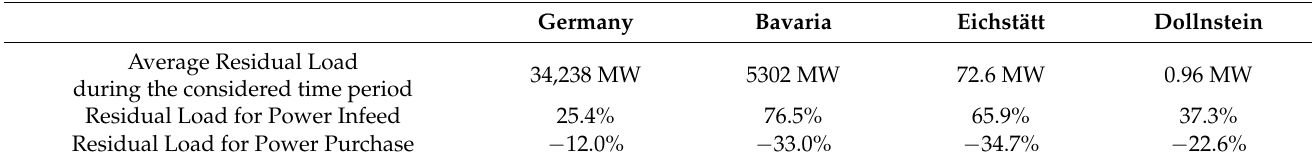
Average Residual Load during the considered time period Residual Load for Power